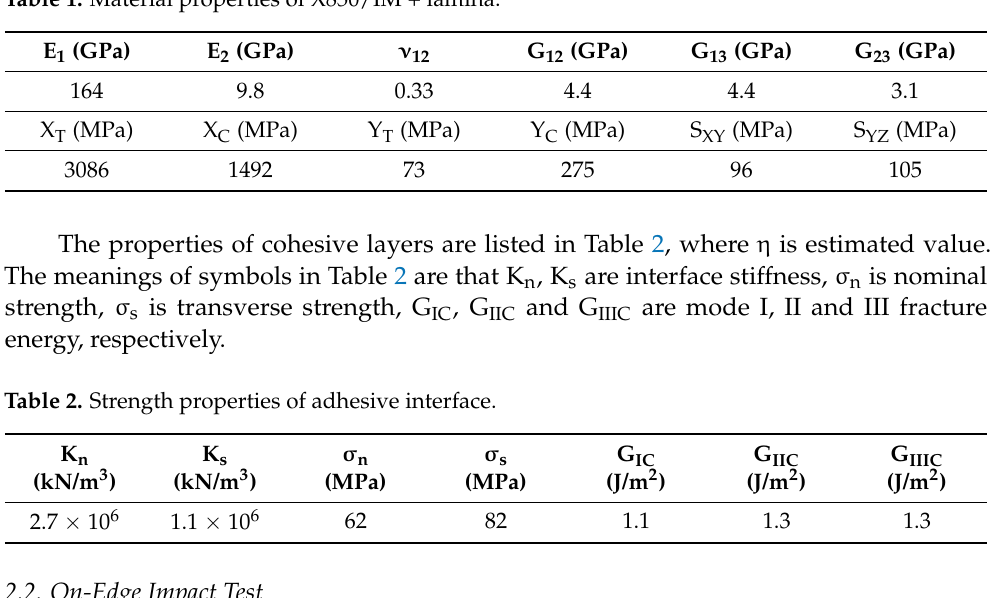
Table 1. Material properties of X850/IM + lamina.